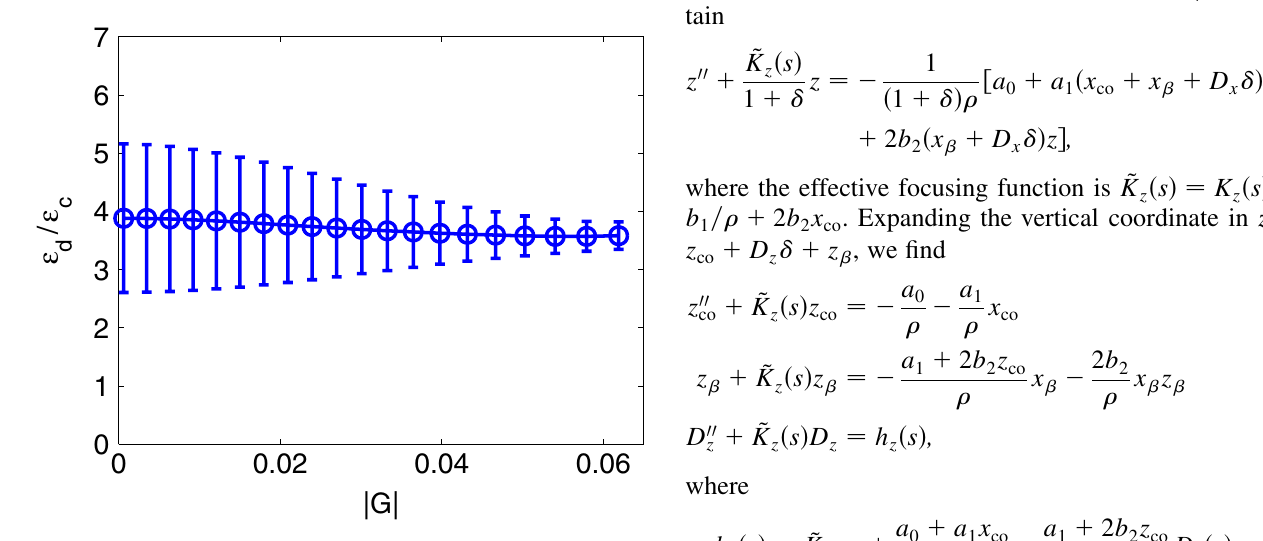
FIG. 2. (Color) The vertical emittance arises essentially from the and the betatron coupling (cid:7) vertical dispersion (cid:7) d cal simulations for a QBA-lattice show that their ratio (cid:7) about four. This ratio depends on lattices to be discussed in the Appendix.